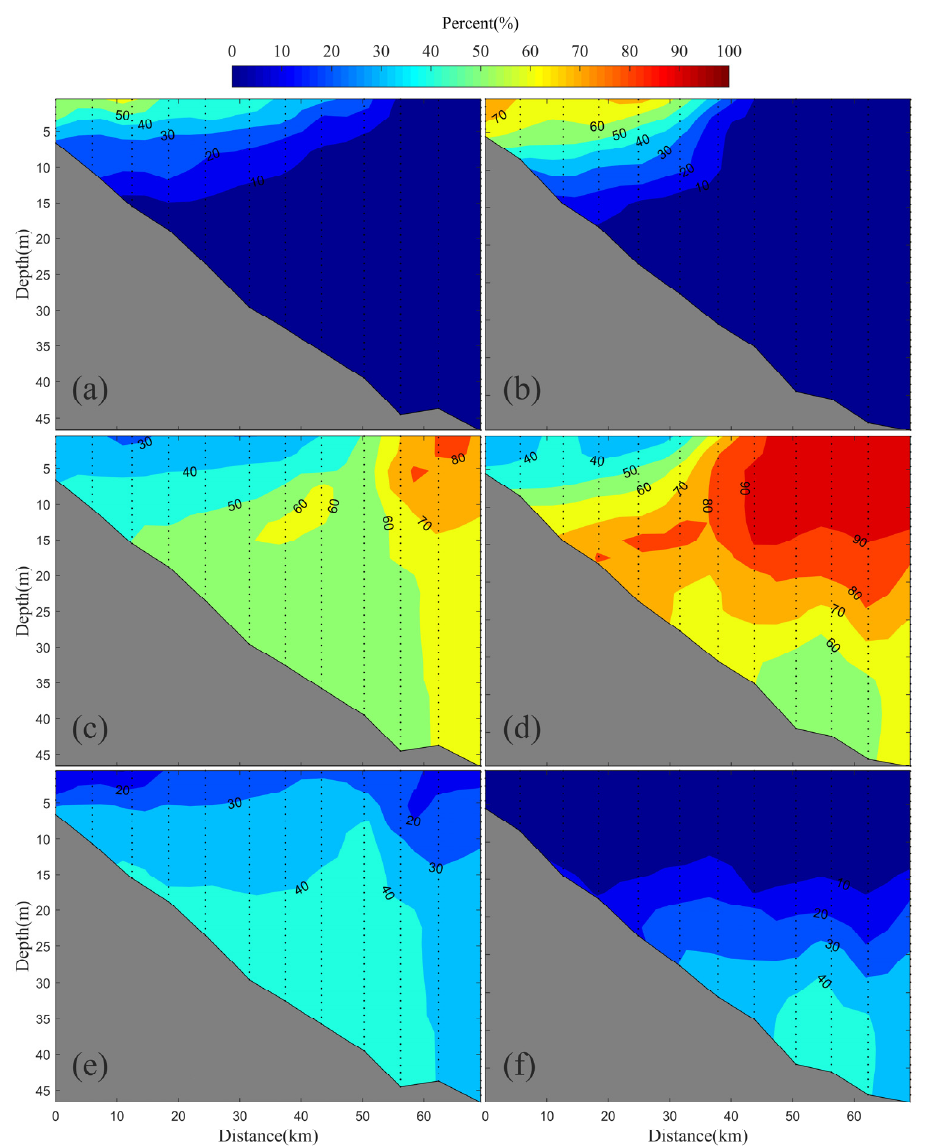
Figure 7. Vertical contributions (%) of PRDW ( a , b ), SCSSW ( c , d ) and SCSSUW ( e , f ) along the T2 section for the April ( a , c , e ) and May ( b , d , f ) cruises.